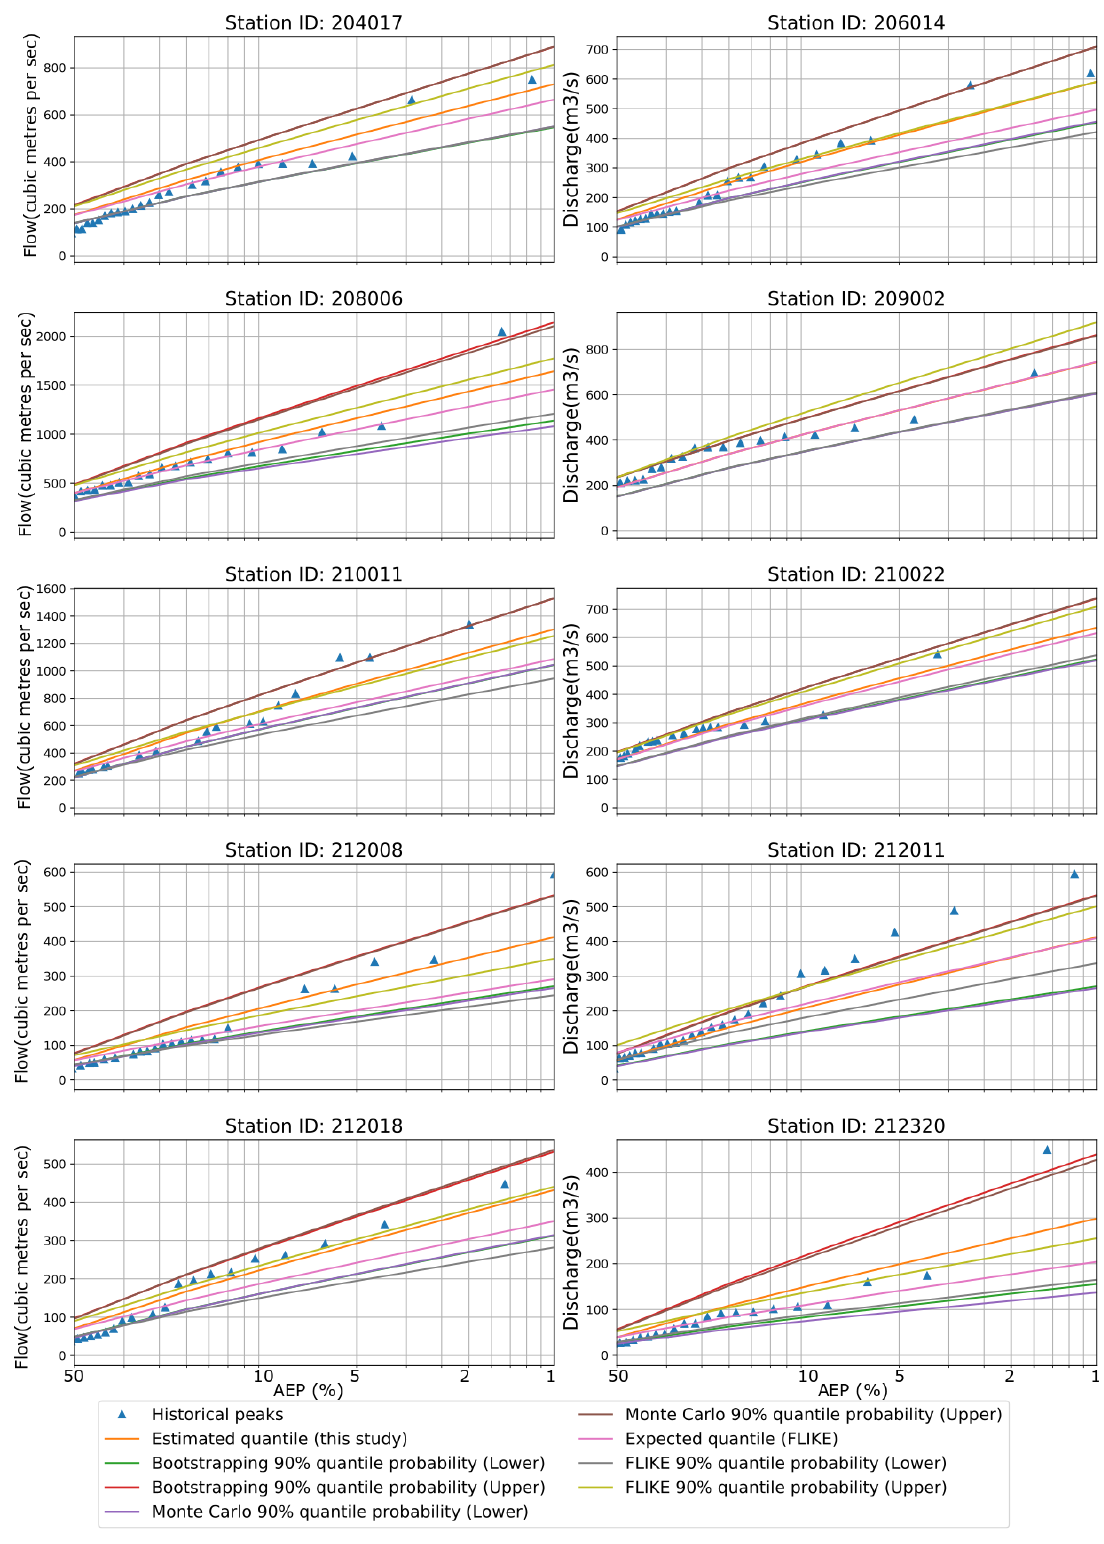
Figure 5. Flood quantiles from FLIKE and EV1 distribution are presented over various AEPs for all 10 stations. CIs are estimated by FLIKE, BS, and MCST. The blue triangle symbolizes historical